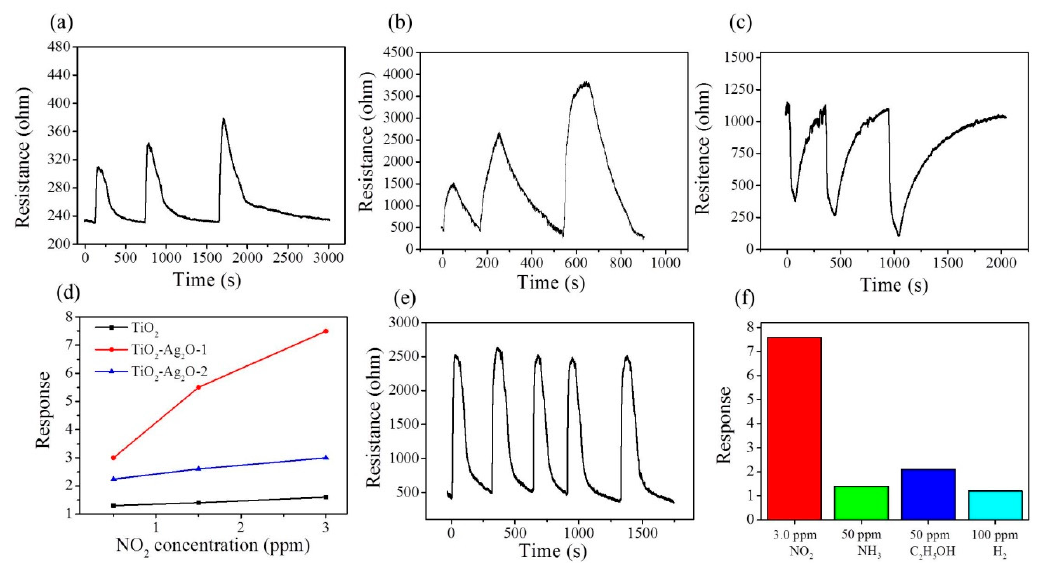
Figure 8. The dynamic response curves of various nanorod sensors to NO 2 gas ranging from 0.5 ppm to 3.0 ppm: ( a ) TiO 2 , ( b ) TiO 2 –Ag 2 O-1, and ( c ) TiO 2 –Ag 2 O-2. ( d ) Summarized gas-sensing